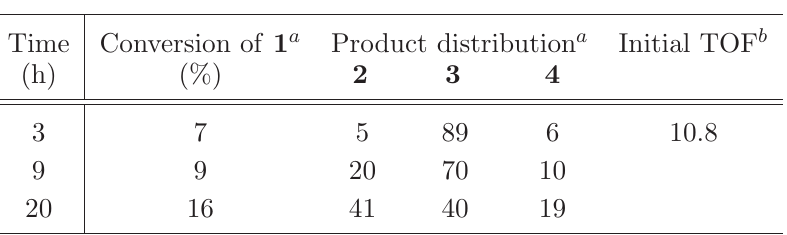
Table 1 Conversion, product distribution and specific activity values in the oxidation of α - methylstyrene with NaOCl solution using complex I as a homogeneous catalyst.